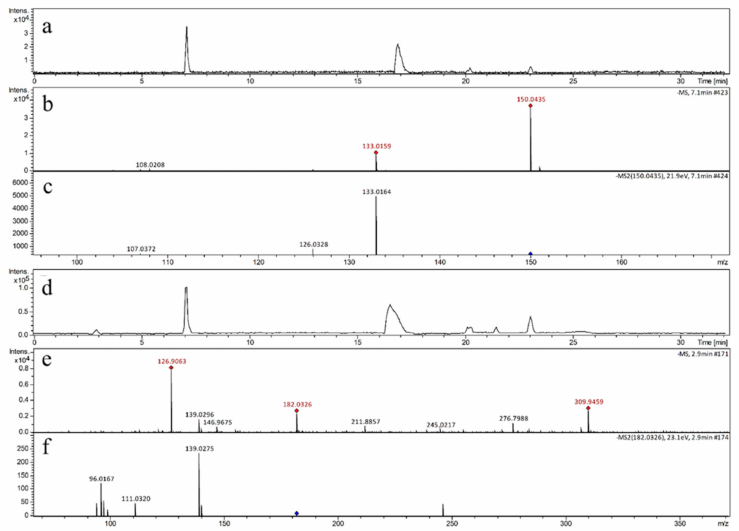
Figure 2. ( a ) The base peak chromatogram of the sample GRM; ( b ) The mass spectrum of GRM; ( c ) The MS/MS spectrum of m / z 150.0435; ( d ) The base peak chromatogram of the sample GRMU; ( e ) The mass spectrum of GRMU; ( f ) The MS/MS spectrum of m / z 182.0326.